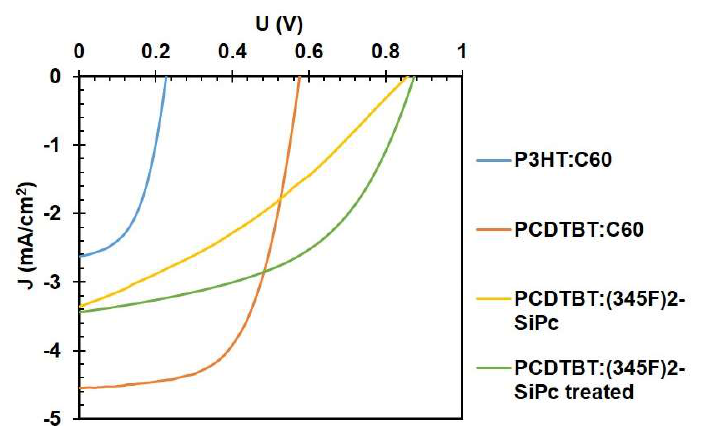
Figure 4. Characteristic current vs. voltage (JV) for PHJ OPV devices where the active layer is P3HT/C 60 , PCDTBT/C 60 , PCDTBT/(345F) 2 -SiPc (93 nm), and PCDTBT/(345F) 2 -SiPc (93 nm) annealed at 150 °C for 30 min devices.